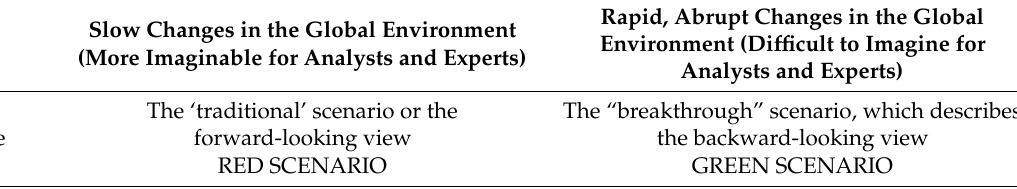
Table 1. A scenario model based on four fields of the projected future for the energy sector. Source: own